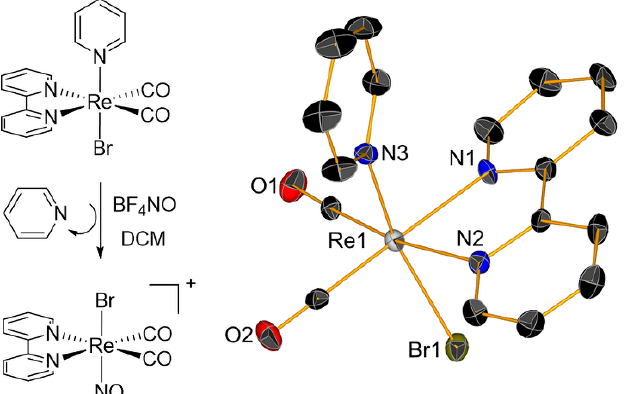
Figure 4. Reaction scheme of attempted synthesis fac -[Re(CO) 2 (NO)(N-N)py] 2+ species from corresponding [Re I (CO) 2 (N-N)(py)Br] complex 8 and crystal structure of the same. Thermal ellipsoids are at 30% probability. Hydrogen atoms are omitted for clarity.